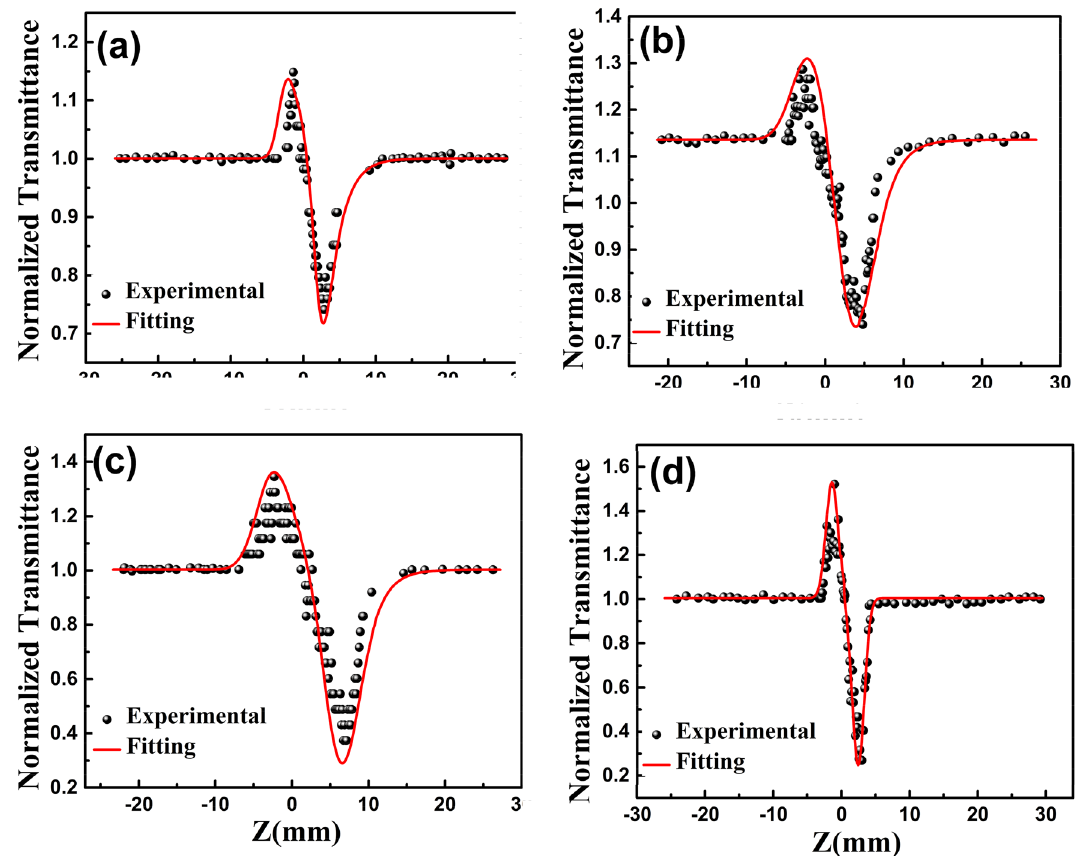
Figure 6. Closed aperture measurements (at 532 nm) of ( a ) GO, ( b ) RGO, ( c ) GO-ZnO, ( d ) RGO-ZnO. Symbols represent experimental data and solid lines represent theoretical